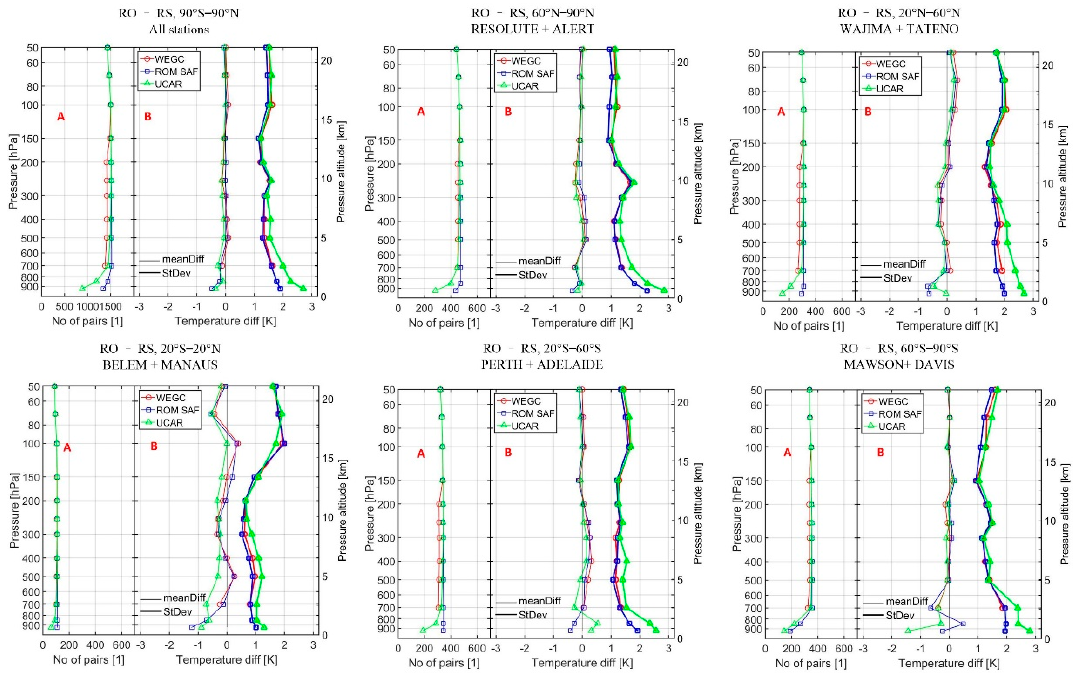
Figure 2. Temperature mean differences (meanDiff) and corresponding standard deviations (StDev) between RO and RS of WEGC, ROM SAF and UCAR over the period of 2007 to 2010 at selected IGRA stations over latitudinal bands of 90°S–90°N, 60°N–90°N, 20°N–60°N, 20°S–20°N, 20°S–60°S, and 60°S ― 90°S; the number of paired samples at all pressure levels is indicated in sub-panel A.